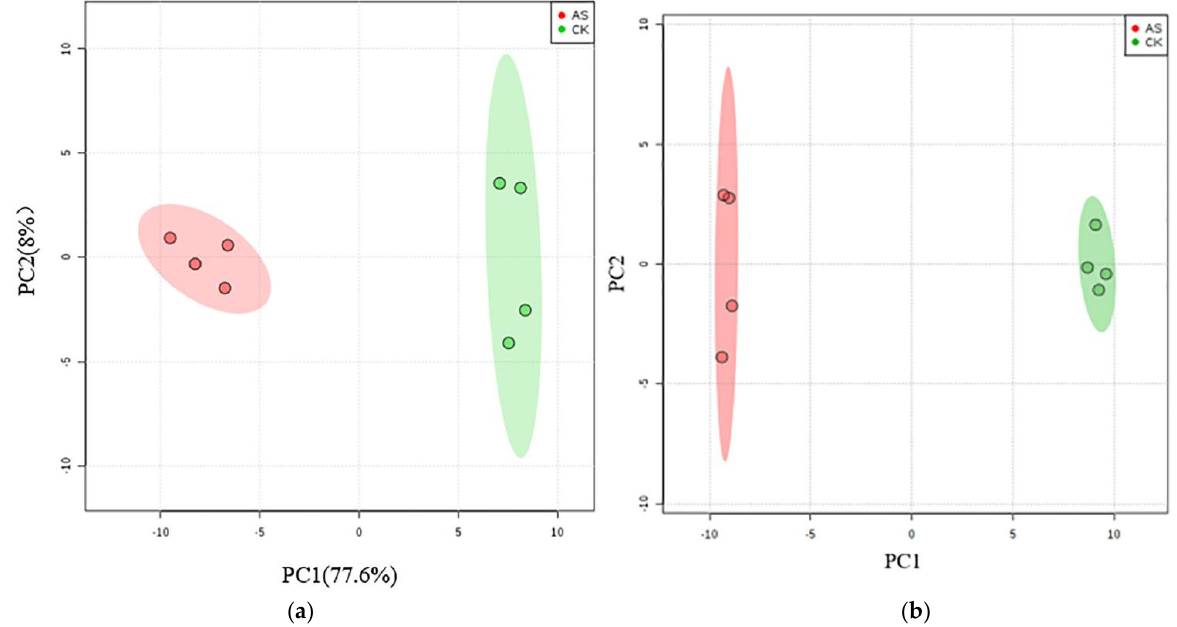
Figure 1. PCA ( a ) and OPLS − DA ( b ) analyses of metabolic profiles of L. chinensis treated with and without alkali stress.